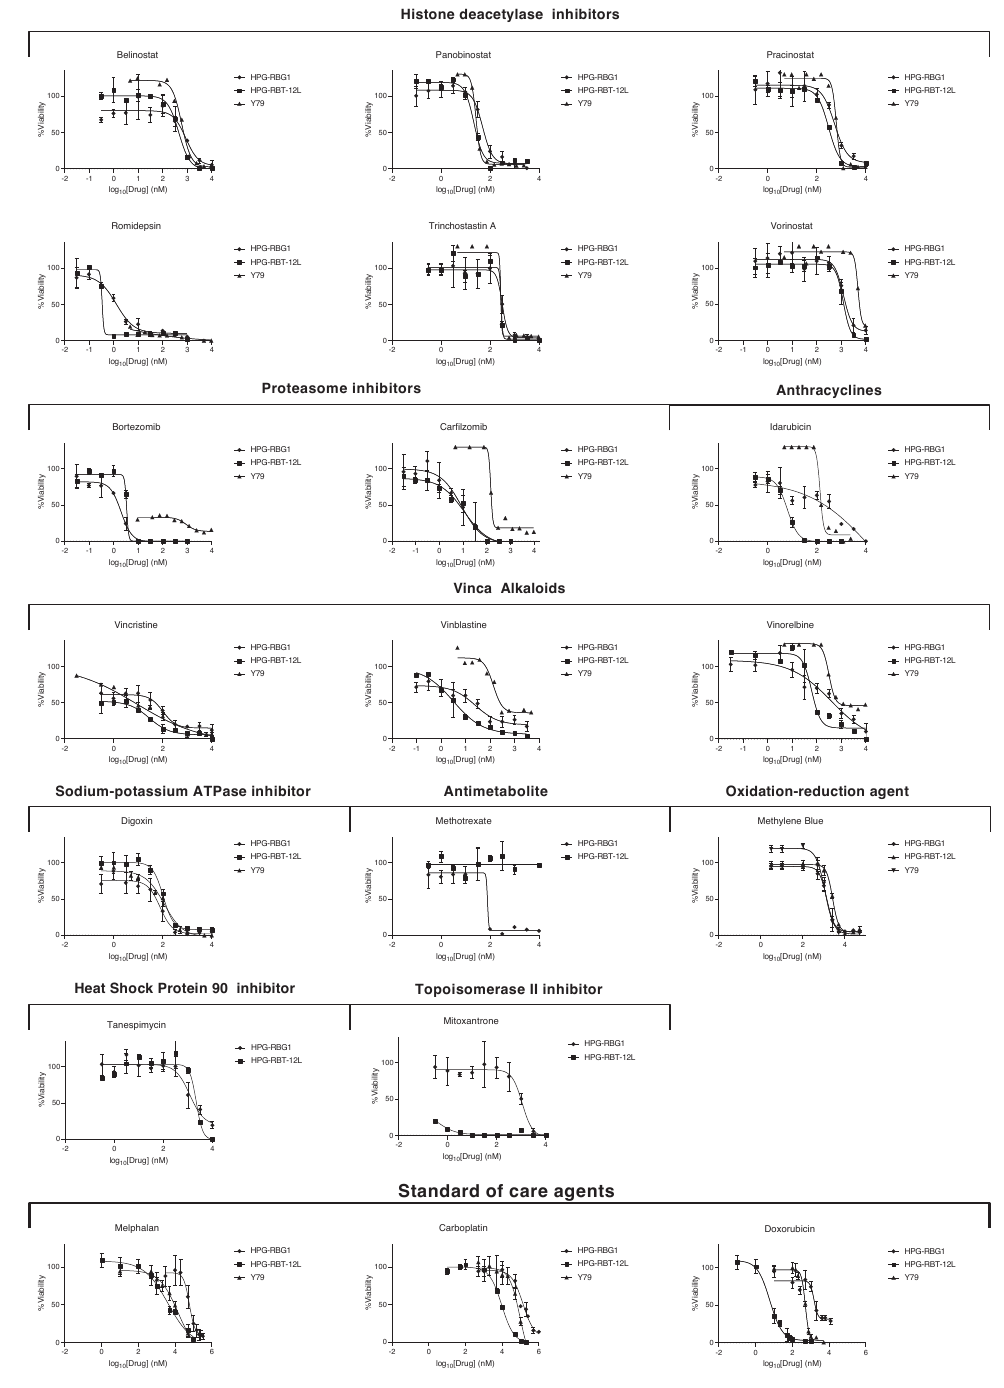
Figure 4. Tumor cell growth inhibition of 17 compounds in HPG-RBG1, HPG-RBT-12L, and Y79 cells. The assay was performed in 384-well plates and cells were exposed to 10 increasing concentrations (0.03 nM–9.6 µ M) and cell viability was determined at 72 h using CellTiter-Glo. Symbols represent percentage of cell proliferation as compared to untreated control cells, expressed as means (SEM) of three independent experiments. The data were fitted using a four-parameter non-linear regression by Graphpad Prism and the derived metrics are described in detailed in Table S4. Dose-response curves for standard-of-care agents were manually performed and are depicted at the bottom